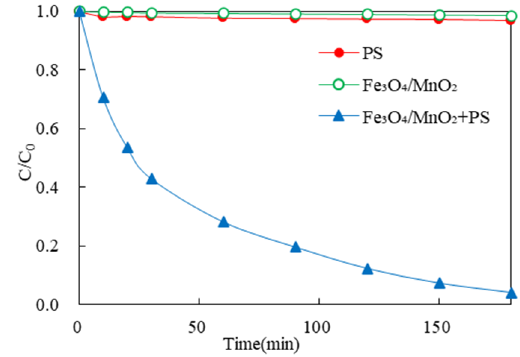
Figure 3. Effectiveness of Fe 3 O 4 / α -MnO 2 MNCs.